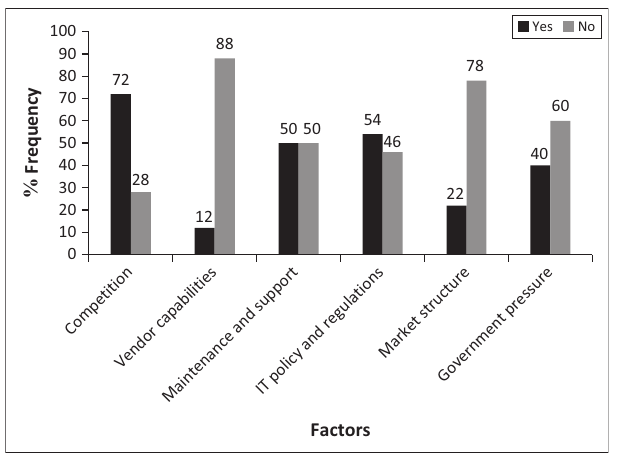
FIGURE 8: Frequency of environmental factors.